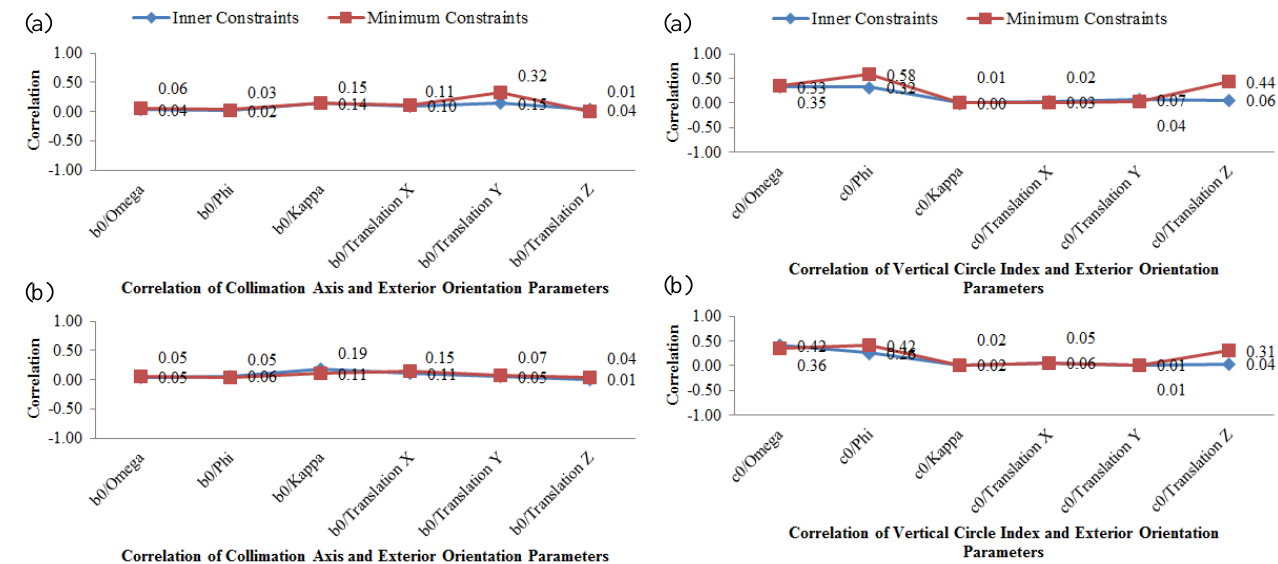
Figure 9. Parameter correlations of vertical circle index and exterior orientation parameters (full network configuration), (a) Faro Photon 120 and (b) Faro Focus